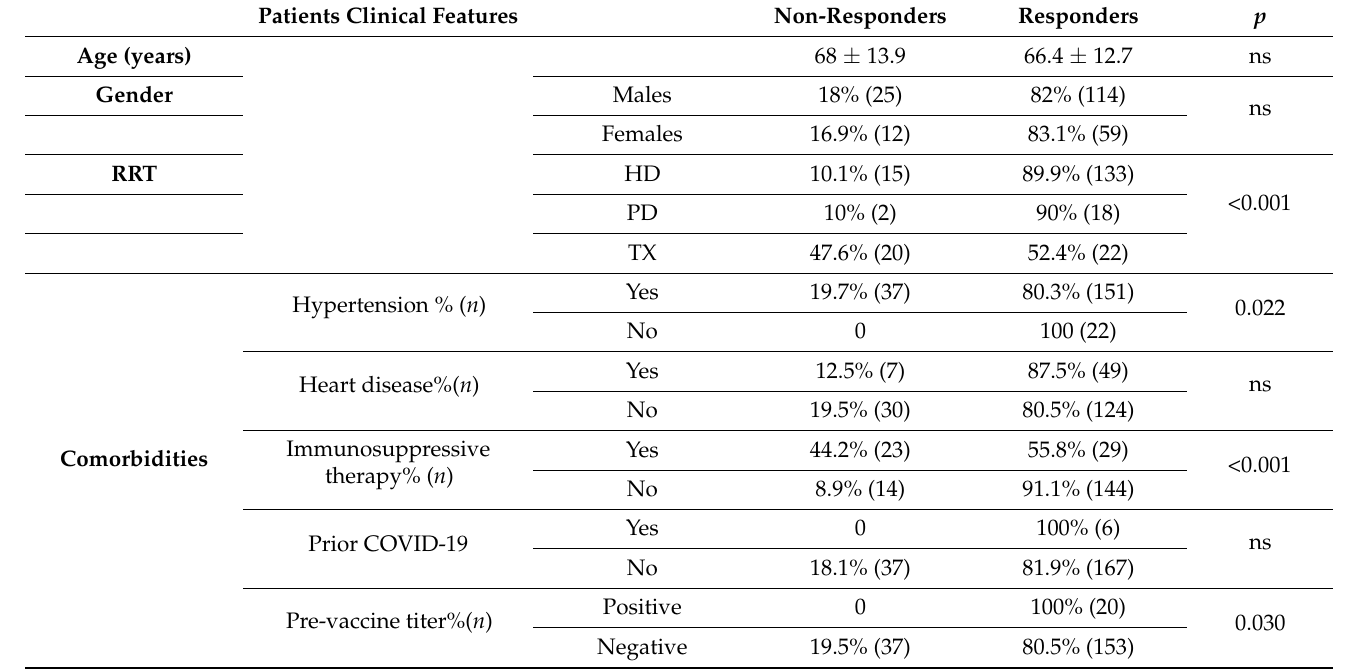
Table 2. Vaccine responsiveness and population characteristics.